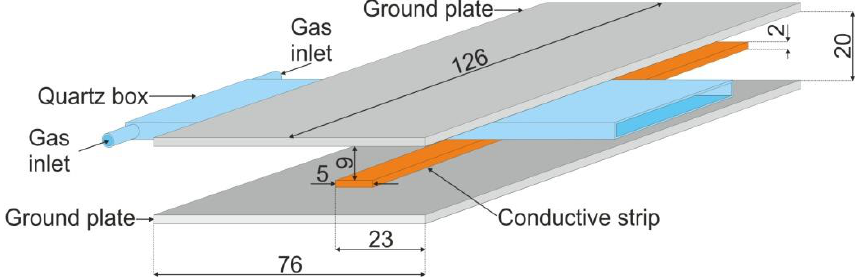
Figure 1. Schematic drawing of the stripline-based MPSS. Dimensions are in mm.